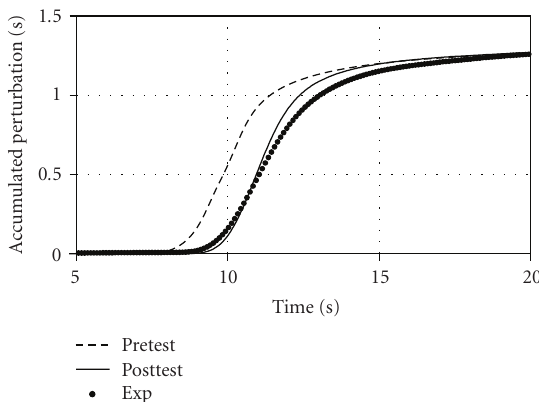
Figure 8: Maximum mixing scalar at core inlet.